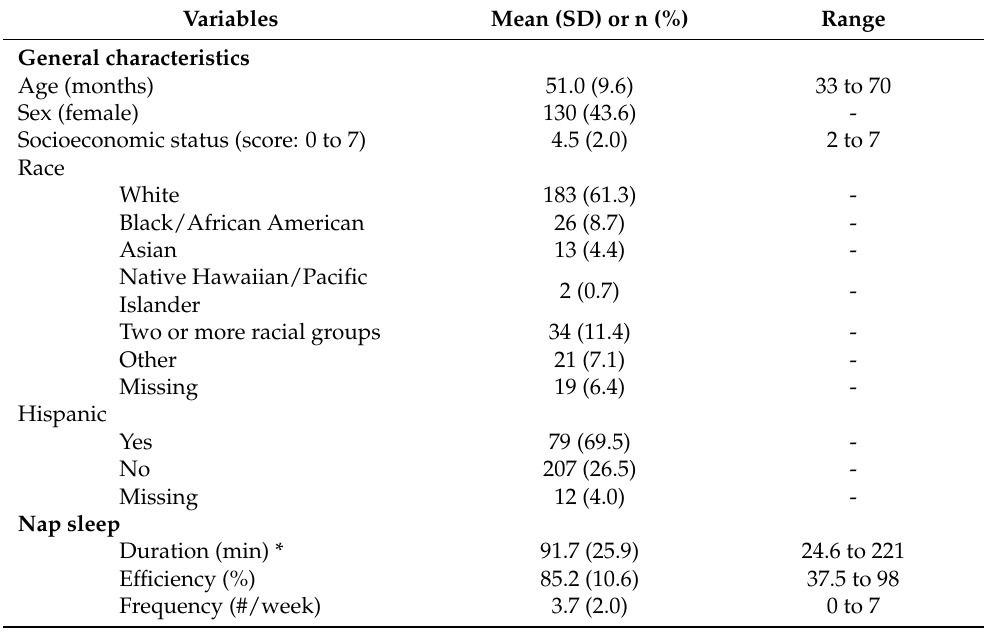
Table 1. Descriptive characteristics of the study sample (n = 298). Variables Mean (SD) or n (%) Range General